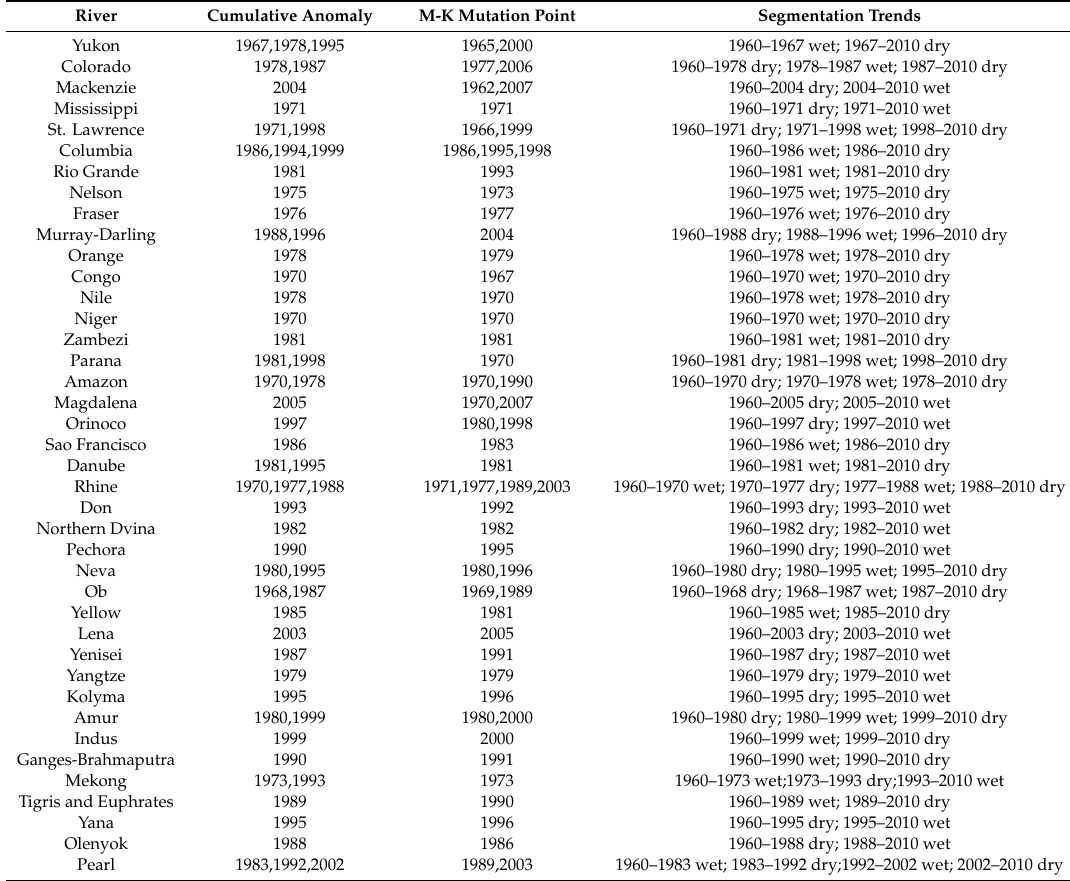
Table 3. Mutation and segmentation trends of the river discharge